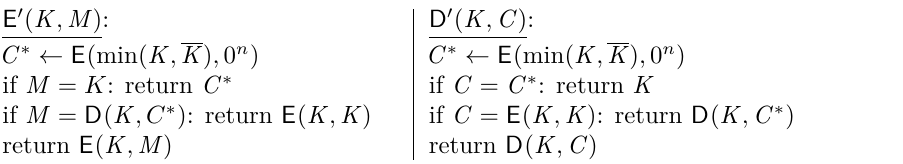
Figure 2: Blockcipher ( E 0 , D 0 ) that is both KDM and RKA secure but not KCA secure.